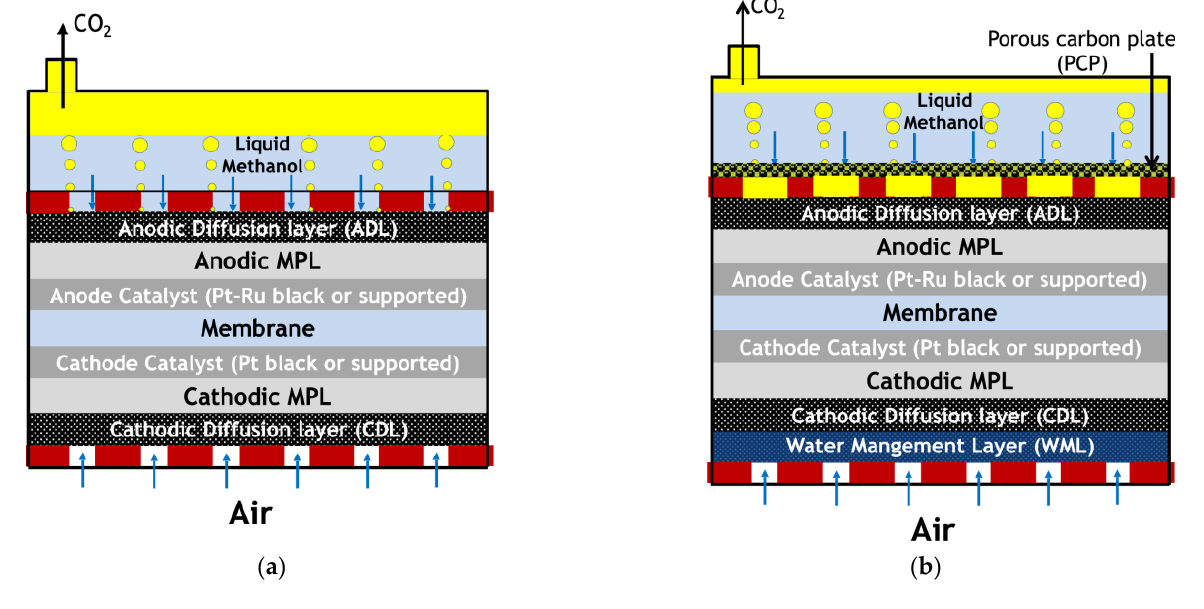
Figure 9. Schematic diagram of passive DMFCs: ( a ) liquid-fed; ( b ) vapor-fed. Reproduced from [120] with permission from Elsevier 2018.